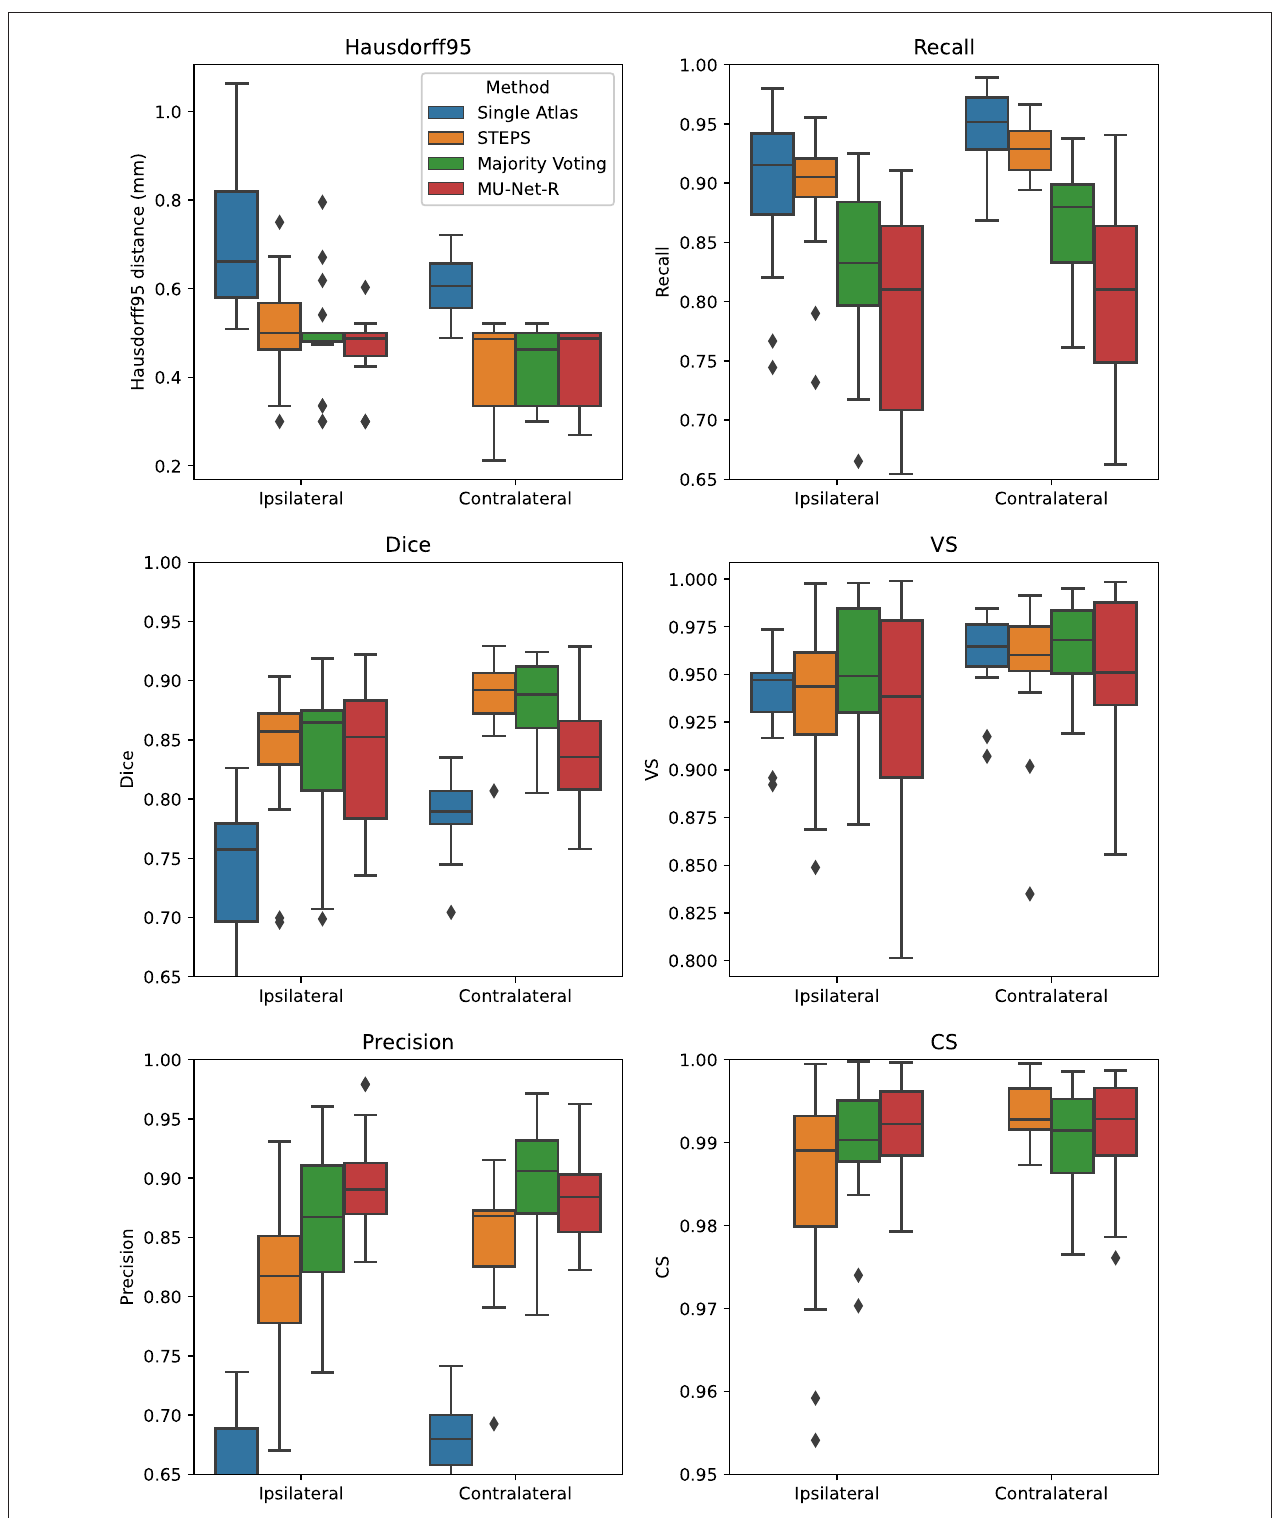
FIGURE 5 | Box plots of all measured quality metrics for the contralateral and ipsilateral hippocampus in the EPITARGET dataset. Single atlas CS measures (not displayed) average at 0.67 for both hippocampi with a standard deviation of 0.02. While MU-Net-R and multi-atlas methods still outperform single-atlas segmentation, in this anisotropic dataset, training MU-Net-R with a smaller dataset, we register a lower performance compared to the EpiBioS4Rx results.